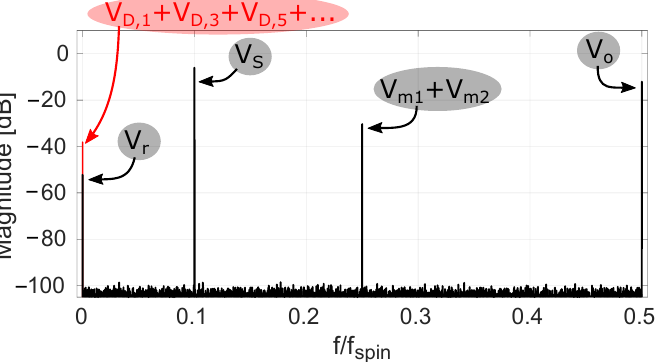
Figure 3. Simulated spectrum with a − 6dBfs input sine wave at frequency 0.1 f spin for V S . Offset tones, corresponding to traditional four-phase spinning, and white noise are present with magnitudes based on our